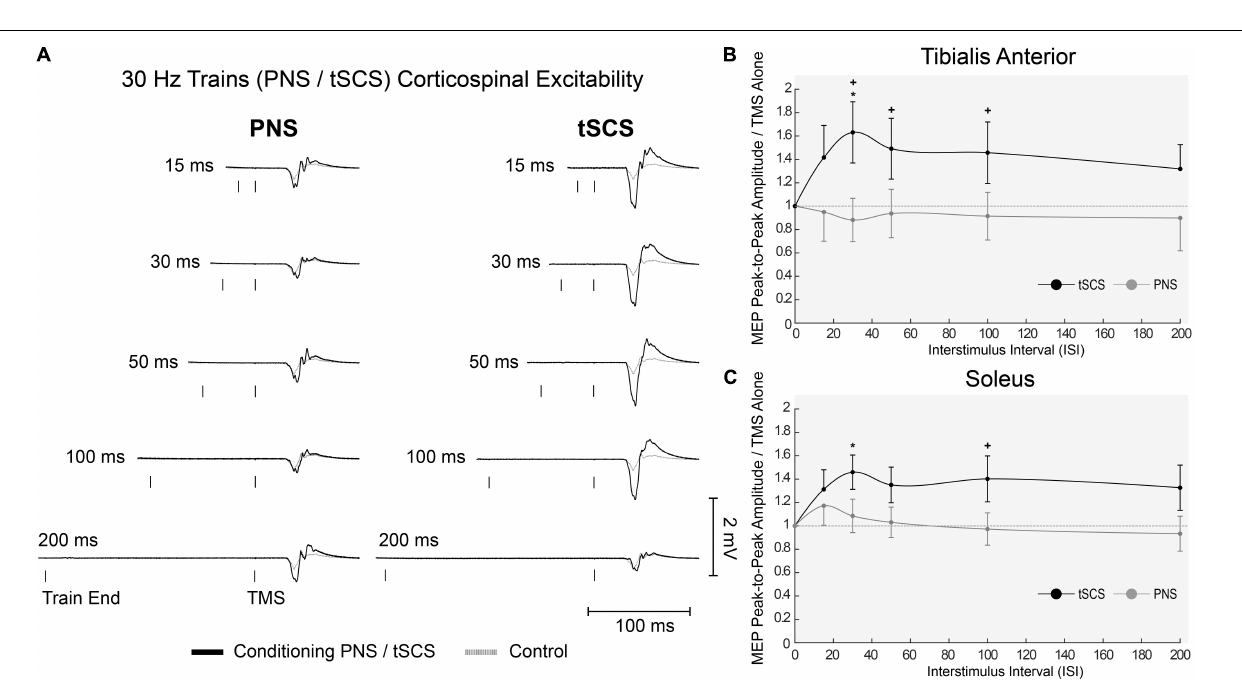
Frontiers in Neuroscience |